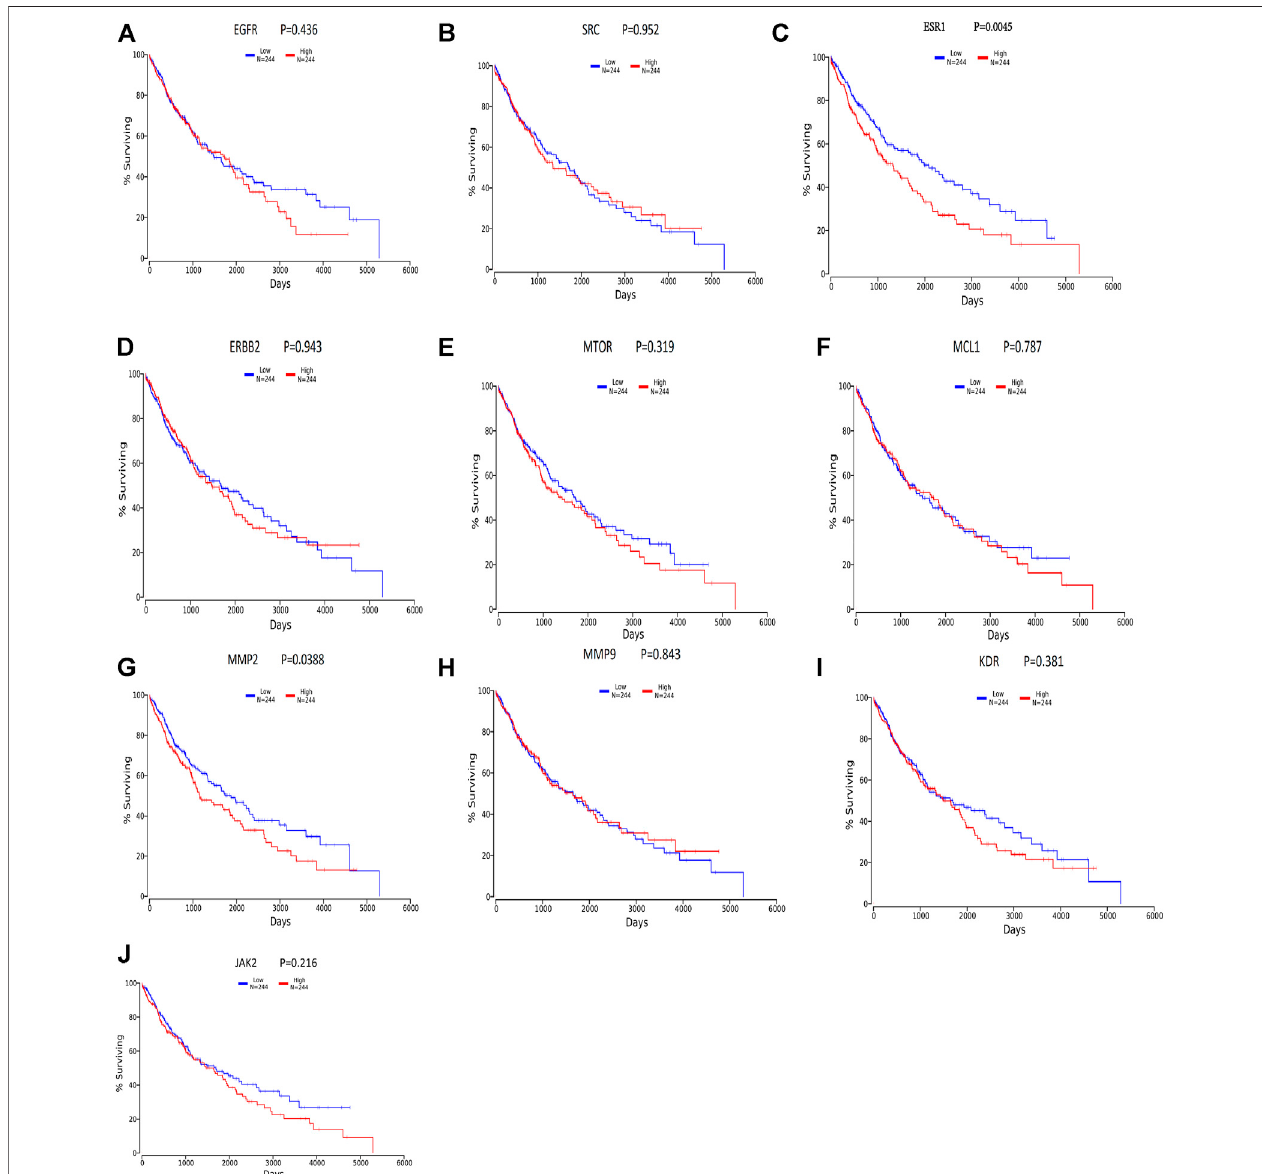
FIGURE 8 | Survival analysis for hub genes by oncolnc. Red lines represent sample groups with high gene expression, while green lines represent sample groups with low gene expression.